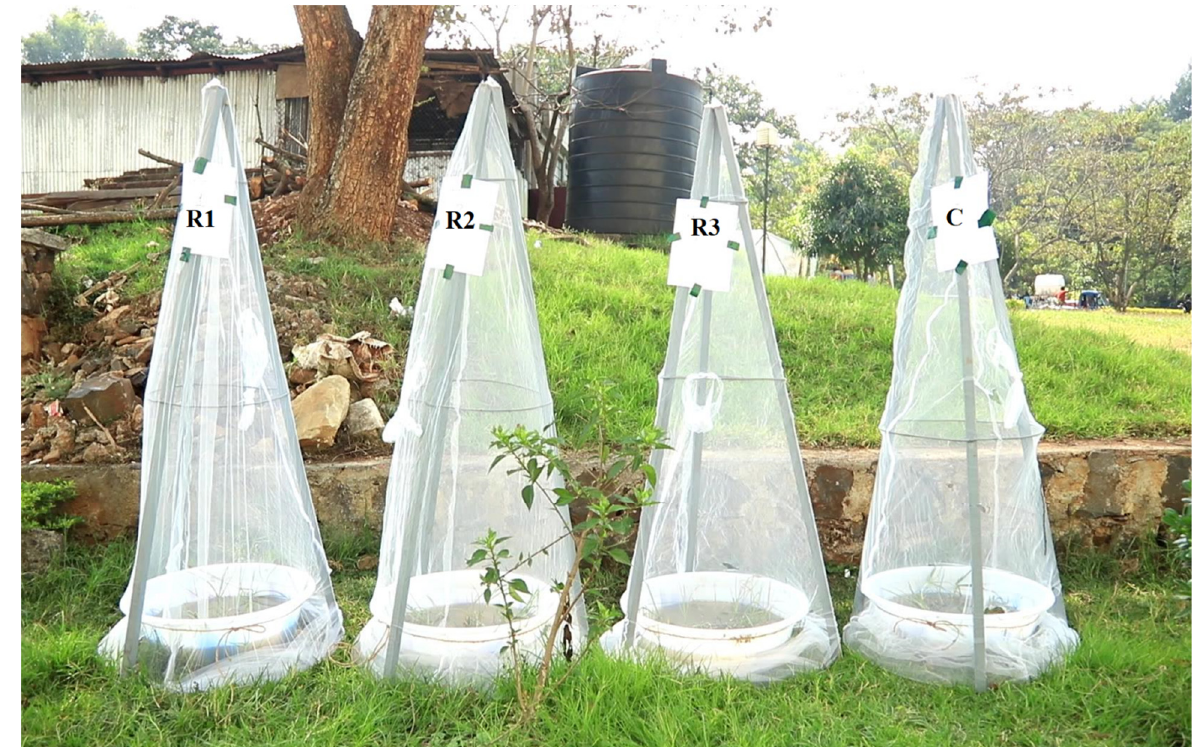
Figure 1. Schematic diagram of the semi-field experiment set-up (R1 = replicate 1, R2 = replicate 2, R3 = replicate 3, C = control).